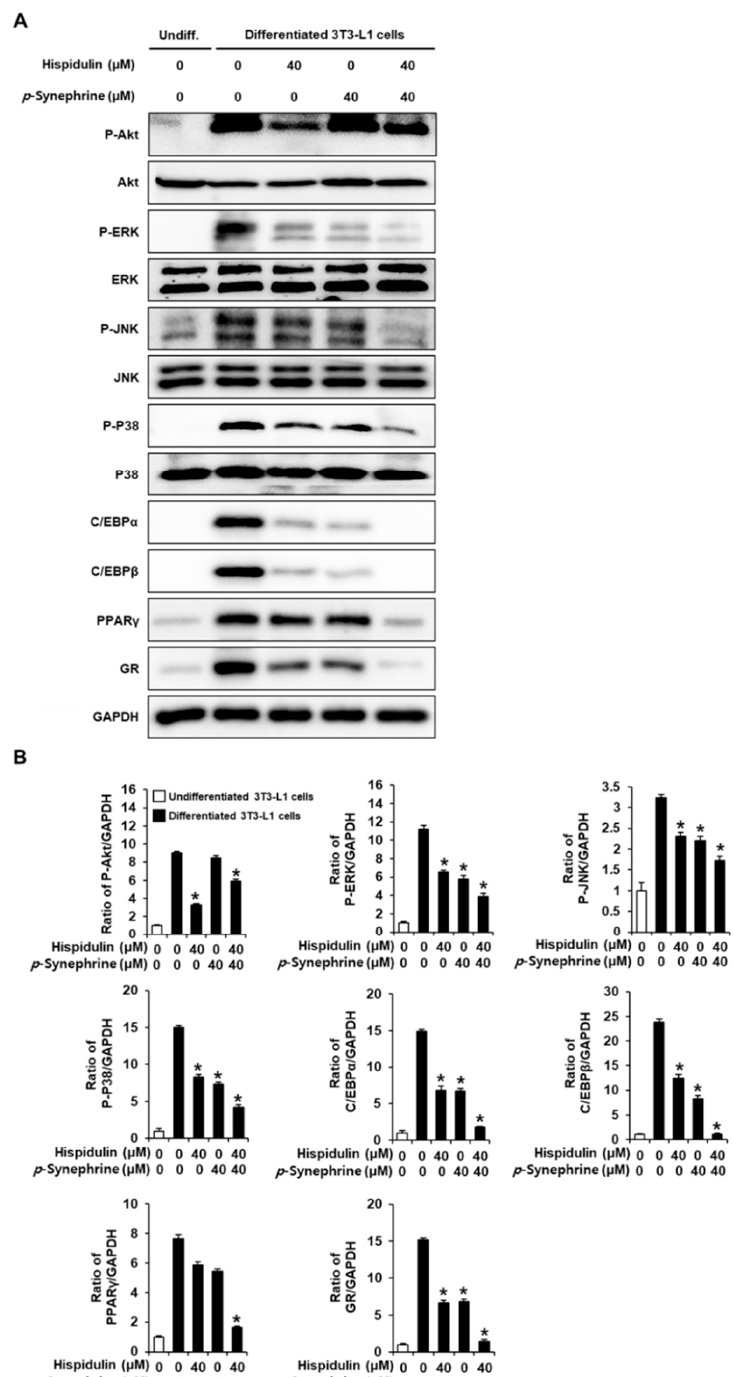
Figure 7. Inhibitory effects of hispidulin and p -synephrine on the expression of adipogenesis-related proteins in differentiated 3T3L-1 cells. ( A ) The protein expression of phospho-Akt (P-Akt), Akt, phospho-extracellular signal-regulated kinase (P-ERK), ERK, phospho-c-Jun-N-terminal kinase (P- JNK), JNK, phospho-P38 (P-P38), P38, peroxisome proliferator-activated receptor gamma (PPAR γ ), CCAAT/enhancer-binding protein alpha (C/EBP α ), C/EBP β , glucocorticoid receptor (GR), and glyceraldehyde 3-phosphate dehydrogenase (GAPDH) in differentiated 3T3L-1 cells on day 8 after treatment with hispidulin and/or p -synephrine. ( B ) Analysis of the ratios of the band intensities of P-ERK, P-JNK, P-P38, PPAR γ , C/EBP α , C/EBP β , and GR in the treated cells compared with those in the untreated differentiated 3T3L-1 cells ( n = 3 independent experiments, * p < 0.05, Kruskal–Wallis nonparametric test). Data are presented as the mean ± SEM.